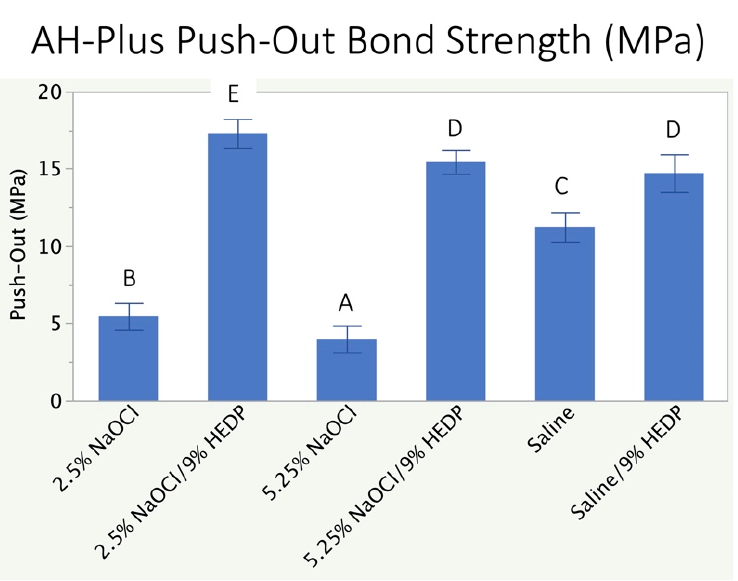
Figure 2. Dislodgment resistance of the epoxy resin sealer under investigation (AH Plus) when root canals were irrigated during and after instrumentation with test and control solutions, with or without the addition of etidronate (Dual Rinse HEDP). Identical superscript letters indicate that there was no difference between data sets at the 5% level (one-way ANOVA, Tukey’s HSD).